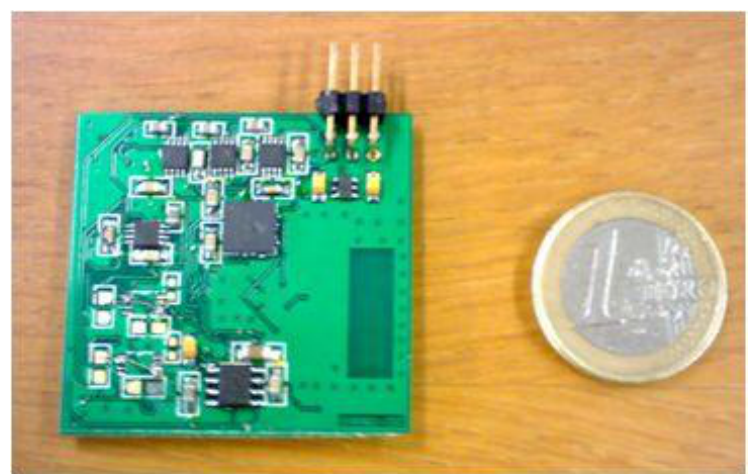
Figure 11. Wireless sensor node prototype